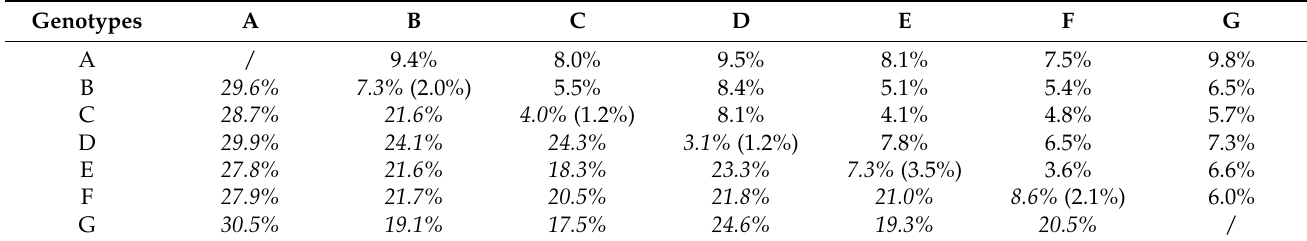
Table 2. The average evolutionary divergence of nucleotide and amino acid sequences within and between genotypes based on the CVA10 VP1 coding